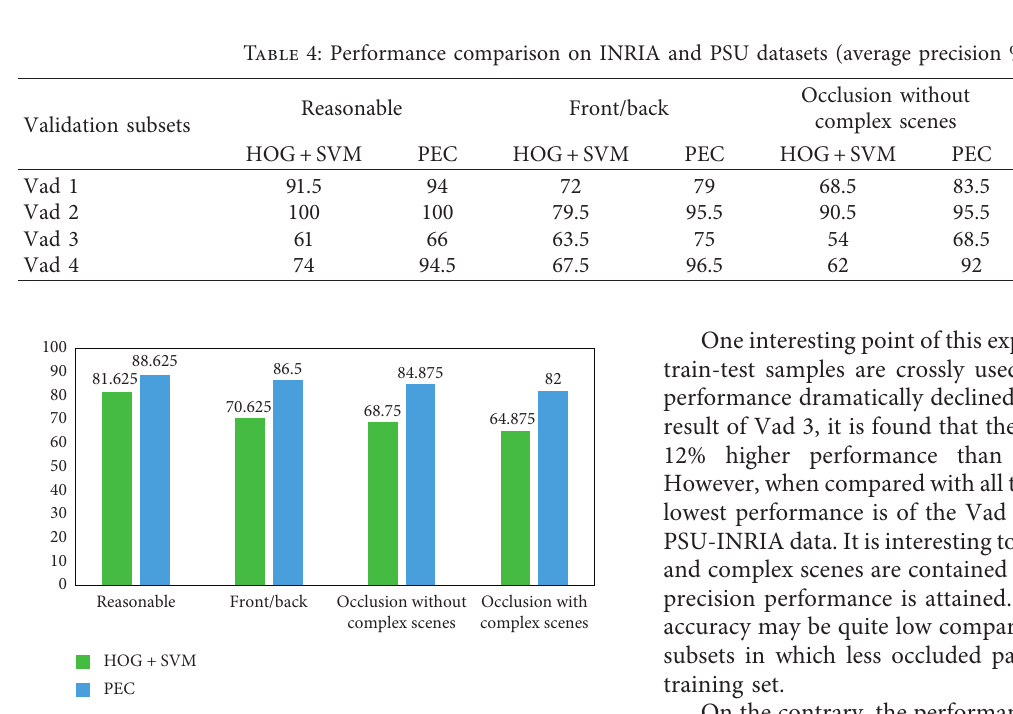
Figure 9: Comparison of the overall performance between the HOG +SVM classifier and the